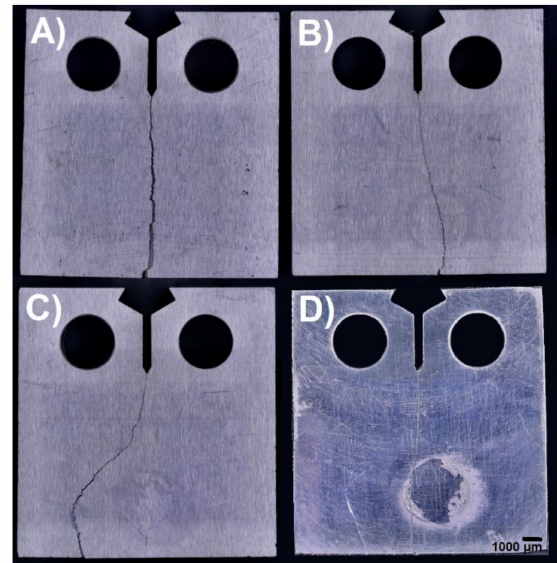
Figure 7. Crack propagation observation for all specimens: ( A )—topology 1; ( B )—topology 2; ( C )—topology 3; ( D )—topology 4.